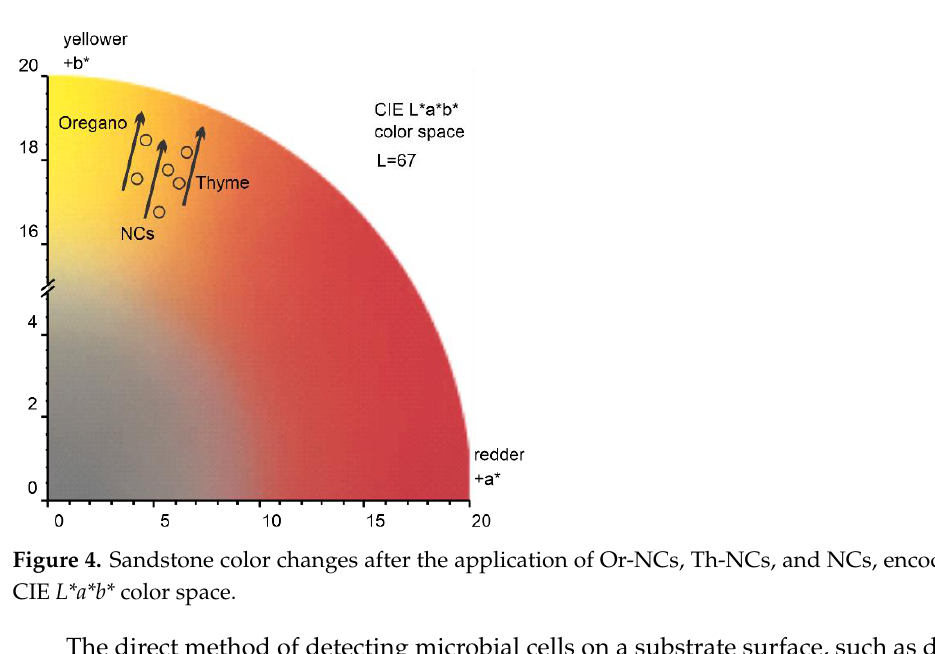
Figure 4. Sandstone color changes after the application of Or-NCs, Th-NCs, and NCs, encoded in CIE L*a*b* color space.